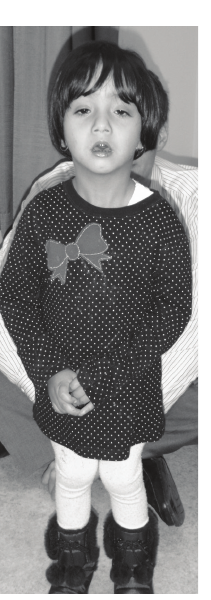
Figure 3: Patient at age of 4 years. Used with permission.